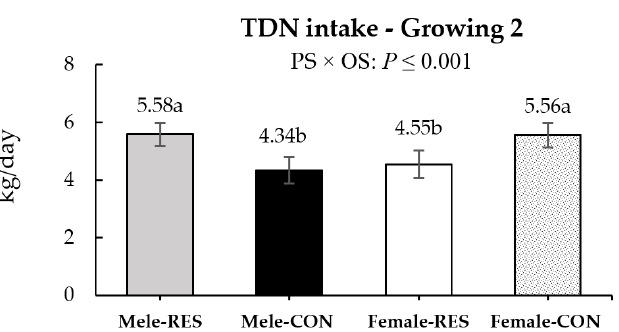
Figure 3. PS × OS interaction effect on the offspring TDN intake in the growing 2 phase. Bars represent mean ± SEM. a,b Different sub-scripts represents different means ( p < 0.05).